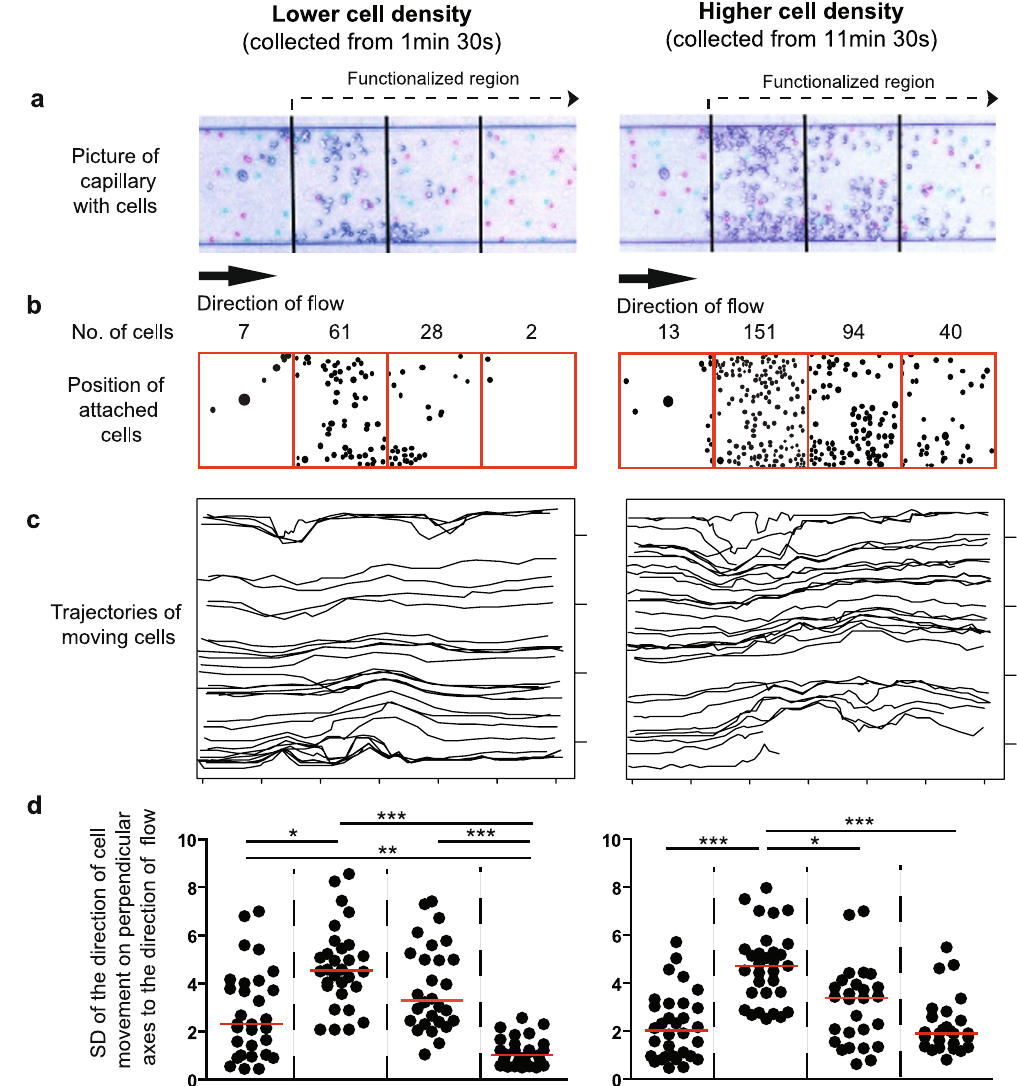
Figure 3. Attached cells in the trapping region perturb the motion of moving cells and force them perpendicular directions to the flow. Routs of moving RBC’s were analysed in the capture region in case of two different bound cell density (right and left panel). ( a ) Two microscopic pictures about the capillary taken in delayed time points (pink and light blue colours) were overlaid to visualize the attached cells (dark blue). Field of vision was divided to four equal regions those were analysed separately, the 2–4 regions were functionalized as indicated. ( b ) Positions of bound cells were indicated by black dots for better visualization. ( c ) Trajectories of 30–30 moving RBC’s were analysed. ( d ) Graph shows the SD of movement of cells in perpendicular direction to the flow of blood. Friedman and Dunn’s statistical tests were applied to reveal significant differences ( * p < 0.05; ** p < 0.01; *** p < 0.001, n =